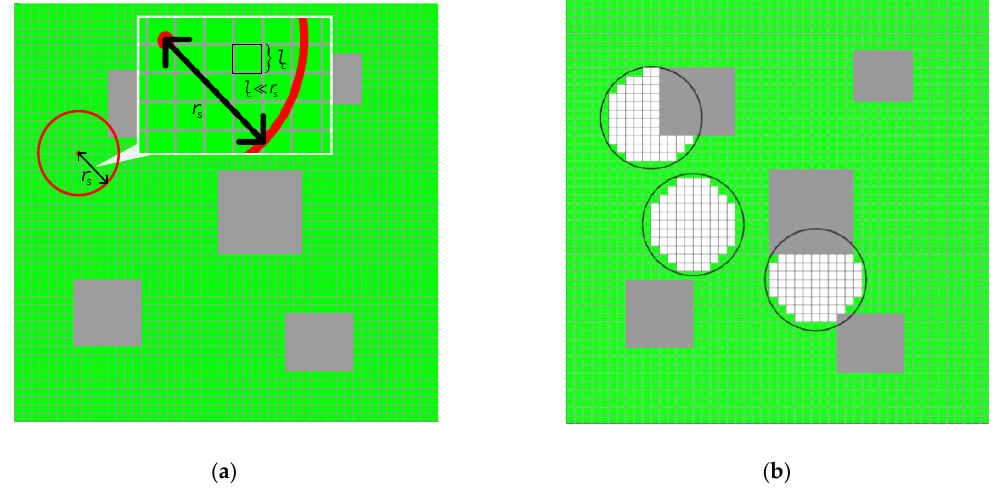
Figure 4. ( a ) Discretization of coverage area. The task region is divided into rectangular cells of 50×50. Grey rectangles refer to the obstacles. ( b ) The coverage of the sensors in the presence of obstacles. White cells indicate that they have been covered by the virtual sensors. Green cells represent that they are uncovered by any virtual sensor.